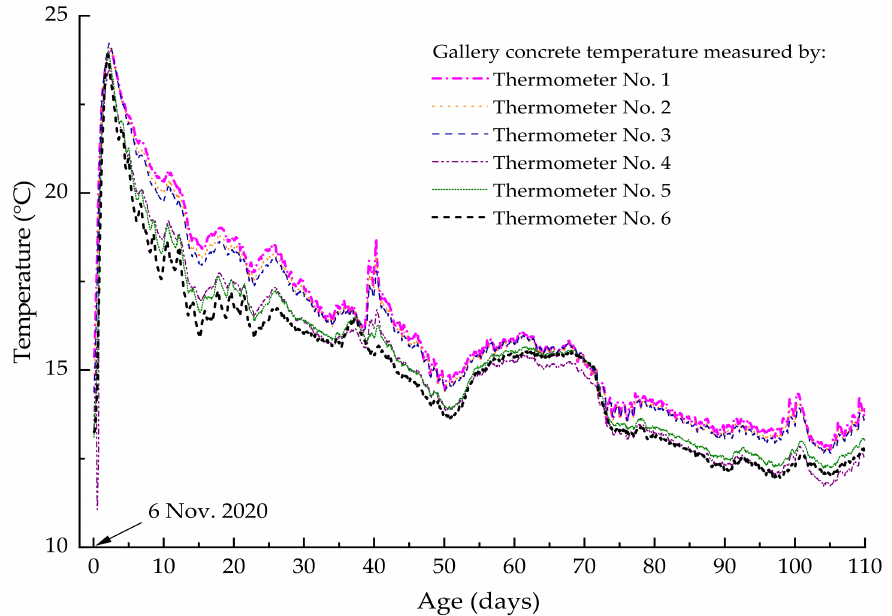
Figure 16. Hourly temperature history of the gallery concretes at different positions measured by the pre-embedded